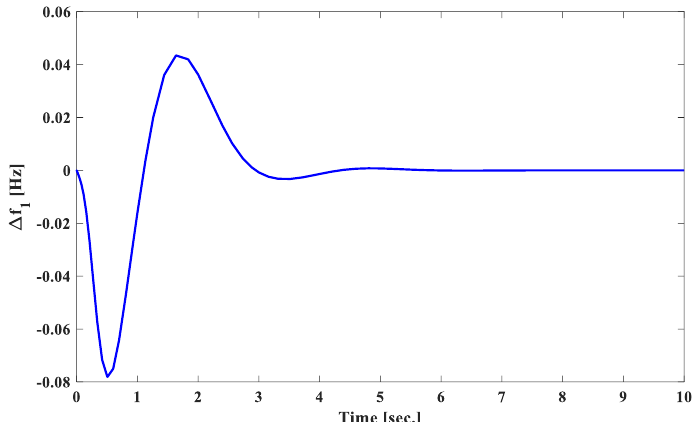
Figure 19. Frequency [Hz] of control area 1 under matched disturbances.